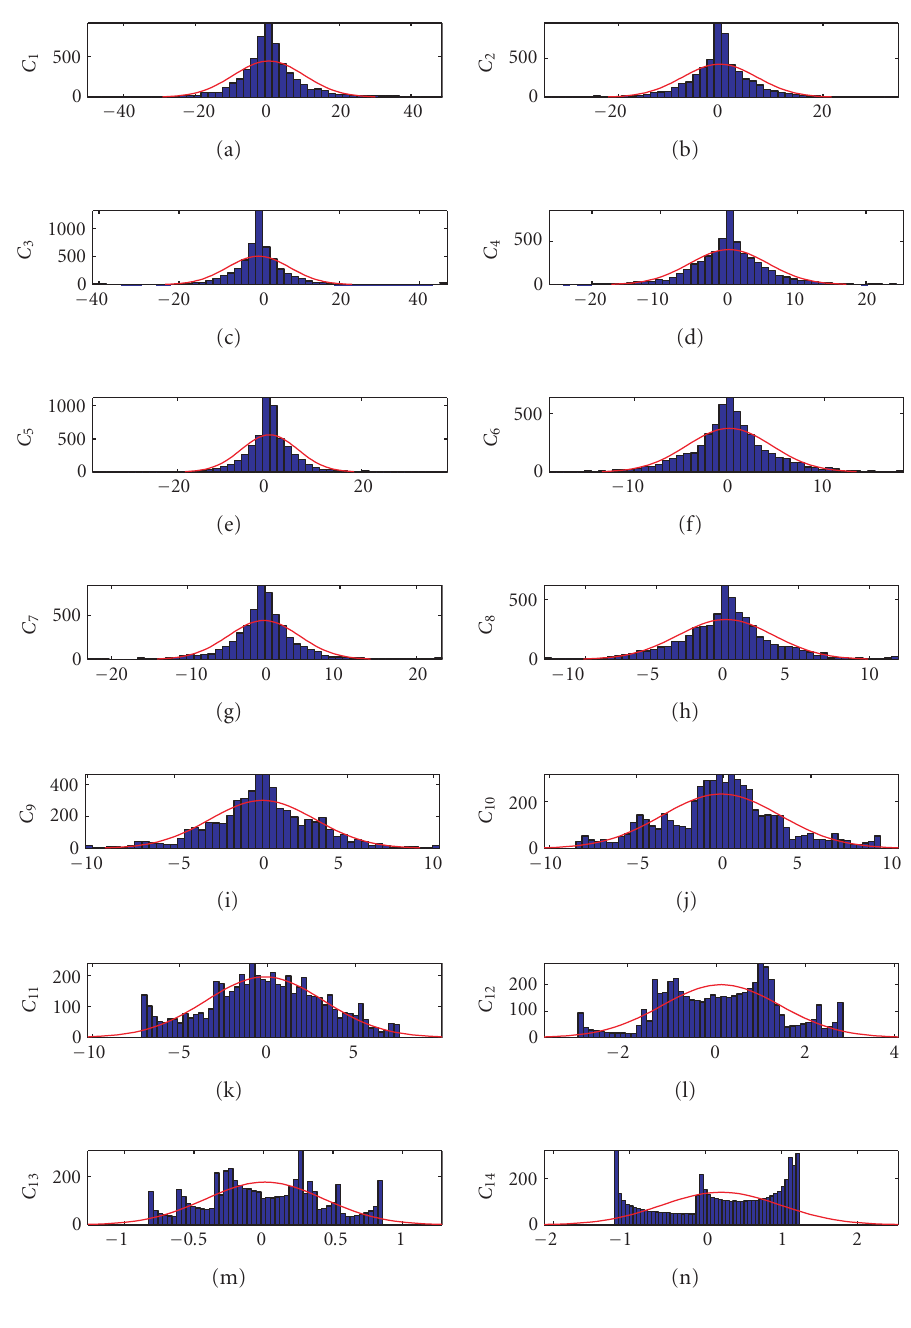
Figure 3.6. Probability distribution functions of the IMF